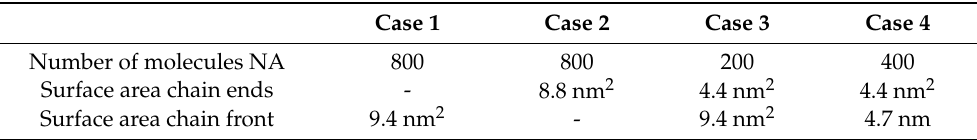
Figure 1. ( a ) Simulated C18 system. Boxes indicate the initial molecules that form the NA. Red: case 1. Green: case 2. Orange, full line: case 3 and orange, dashed line: case 4. ( b ) Multiple periodic NA of case 3 and ( c ) of case 4. Table 1. Overview of initial number of molecules per NA and surface area surrounded by liquid PCM for one box with a total number of 1600 C18 molecules.